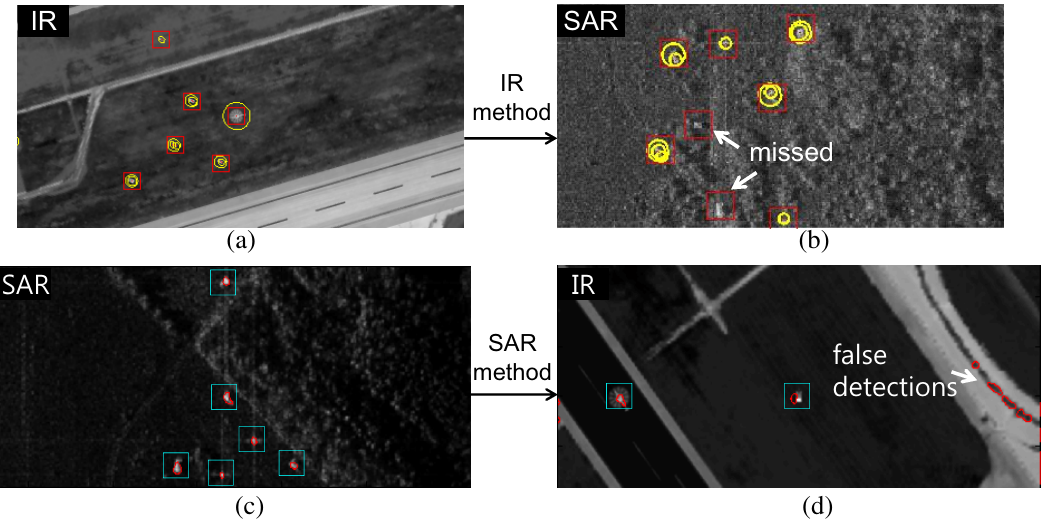
Figure 2. Problems of SAR and IR target detection by applying crossed methods: ( a ) IR target detection results using a Scale Invariant IR target detector [22]; ( b ) SAR target detection results using the same IR target detector; ( c ) SAR target detection results using an Active Contour-based SAR target detector [33]; ( d ) IR target detection results using the same SAR target detector. The Rectangles denotes the ground truths and the rounded edges denotes the detection